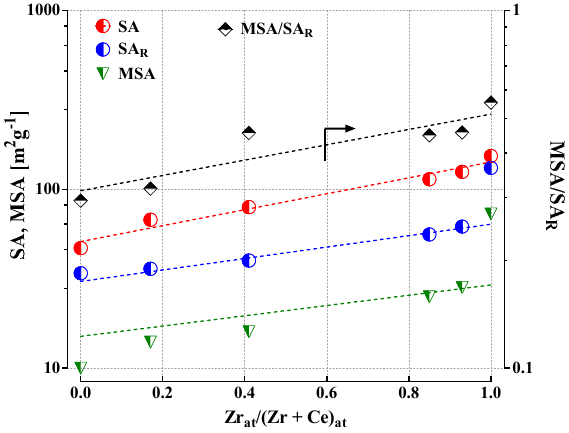
Figure 1. Influence of carrier composition on the textural properties of Cu-Zn based catalysts.